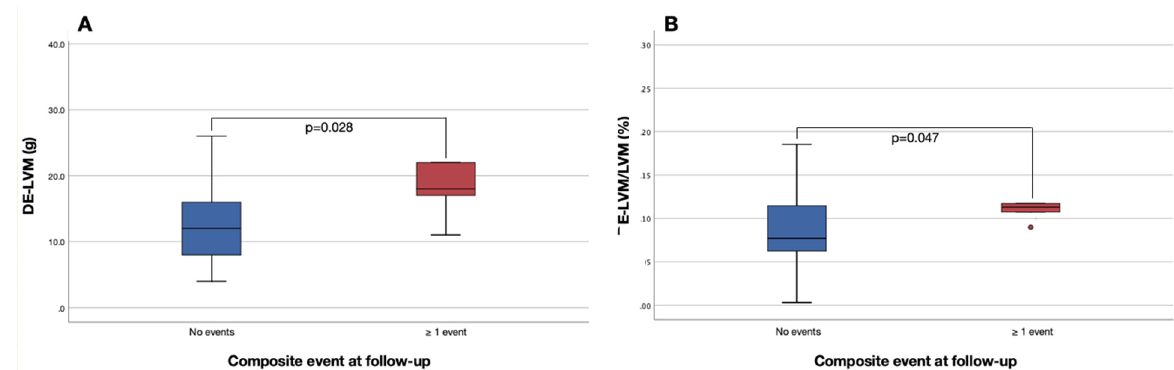
Figure 2. Box-plots for ( A ) left ventricular mass with delayed enhancement (DE-LVM) in patients who meet or do not meet the primary endpoint; ( B ) percentage of DE-LVM to the total left ventricular mass in patients who meet or do not meet the primary endpoint. DE, delayed enhancement; LVM, left ventricular mass.